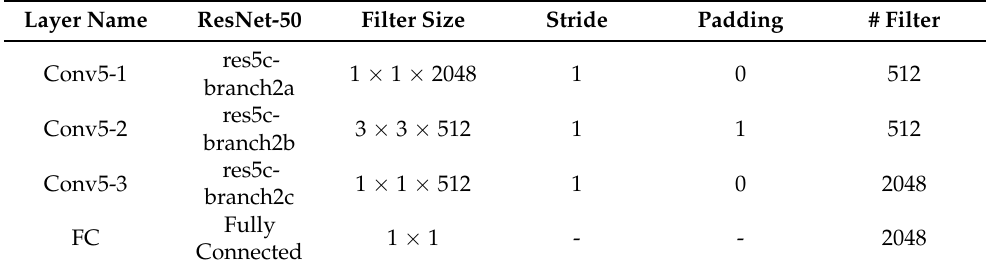
Table 3. Fine-tuned ResNet-50 architecture that we used in our